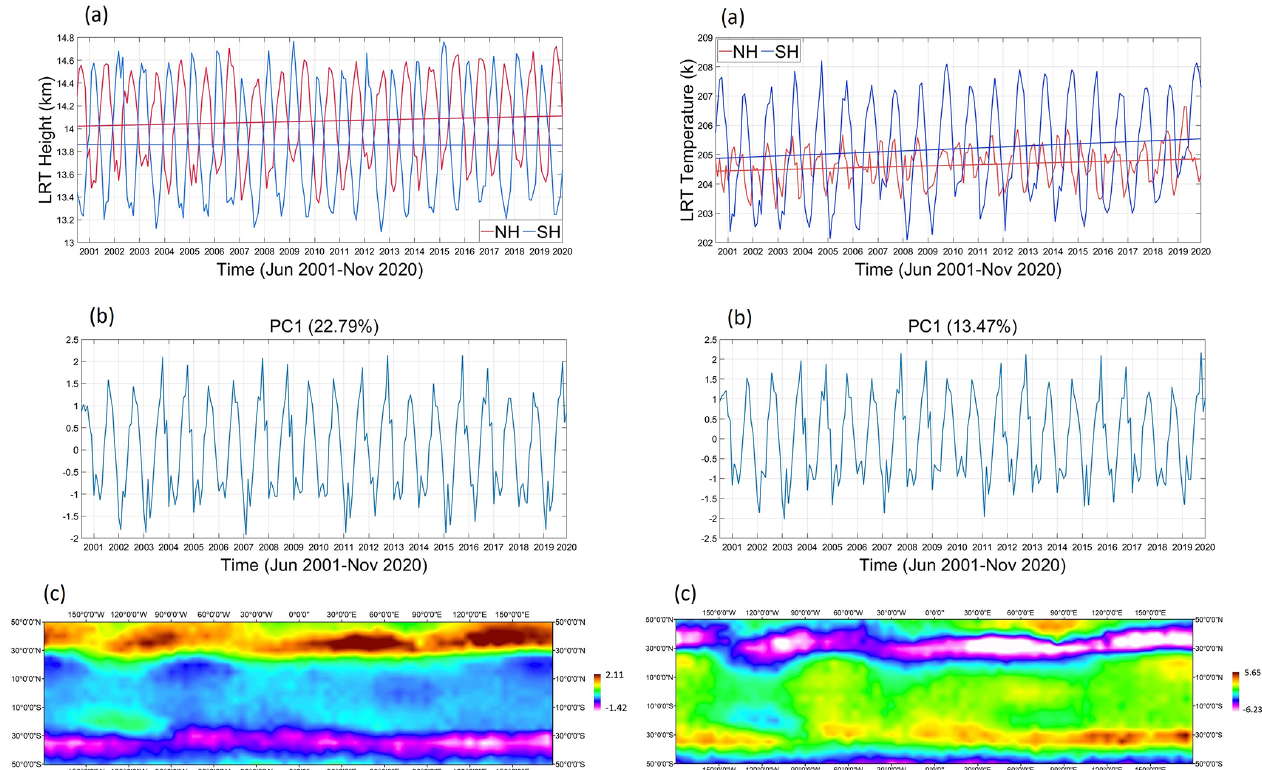
Figure 8. GNSS-RO-based LRT height (left) and temperature (right). In (a) temporal time series and (b) temporal variability given by PCA1, and (c) spatial variability map given by